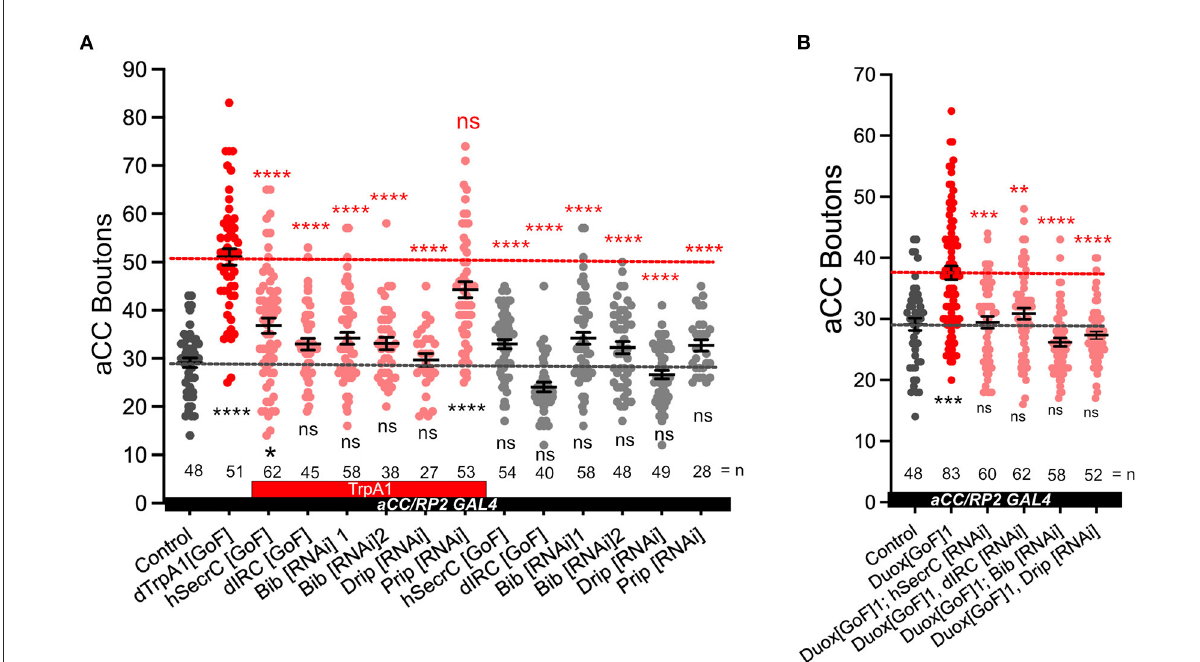
FIGURE3 Aquaporins Bib and Drip are required for activity-regulated plasticity at the neuromuscular junction. (A) Dot-plot quantification shows NMJ bouton number increases in response to cell-specific activity and the rescue of the phenotype when secreted catalases are expressed [GoF] or aquaporins Bib or Drip are knocked down; control ( aCC/RP2-Gal4/ + ). (B) Dot-plot quantification shows NMJ bouton number increases in response Duox[GoF] and the rescue of the phenotype when secreted catalases are expressed or aquaporins Bib or Drip are knocked down; control ( aCC/RP2-Gal4/ + ). Mean ± SEM, Kruskal-Wallis test, * p < 0.05, ** p < 0.01, *** p < 0.001, and **** p < 0.0001. ns = not significant. Red asterisks indicate statistical comparisons with the dTrpA1[GoF] group, while black asterisks comparison with the un-manipulated wild type